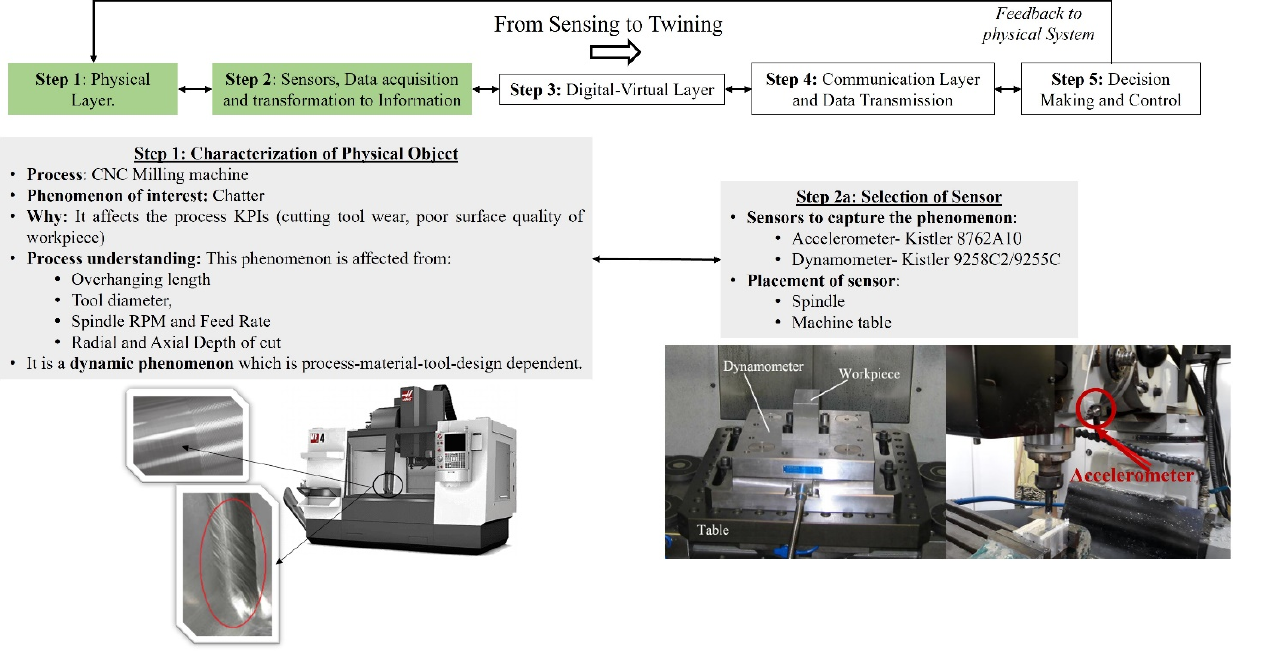
Figure 10. Description of physical object and selection of sensor to capture critical phenomenon [73,103,104].